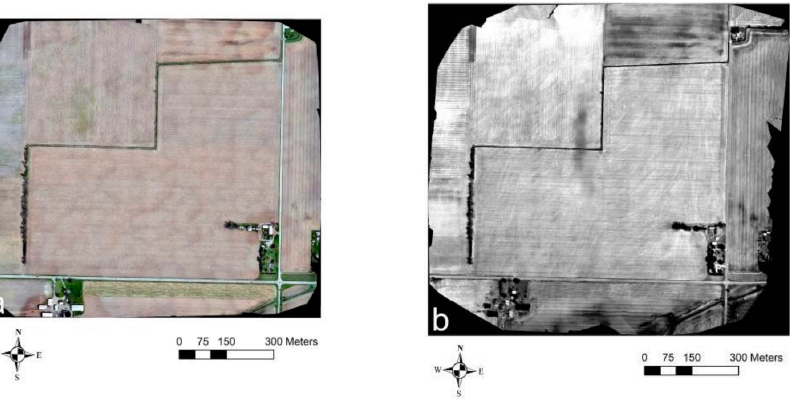
Figure 9. Site-3 UAV survey results from 7 May 2018: ( a ) VIS-C and ( b ) TIR orthomosaic